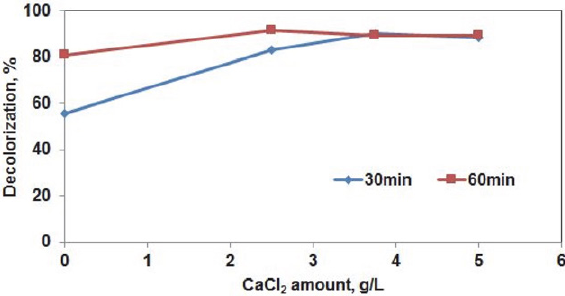
Fig. 6. Effect of CaCl 2 amount on the decolorization of DB-22 (ini- tial dye concentration: 0.040 g/L, initial temperature: 25 °C, original pH, H 2 O 2 amount: 2.78 g/L, m-ZZF amount: 3 g/L, UV light)